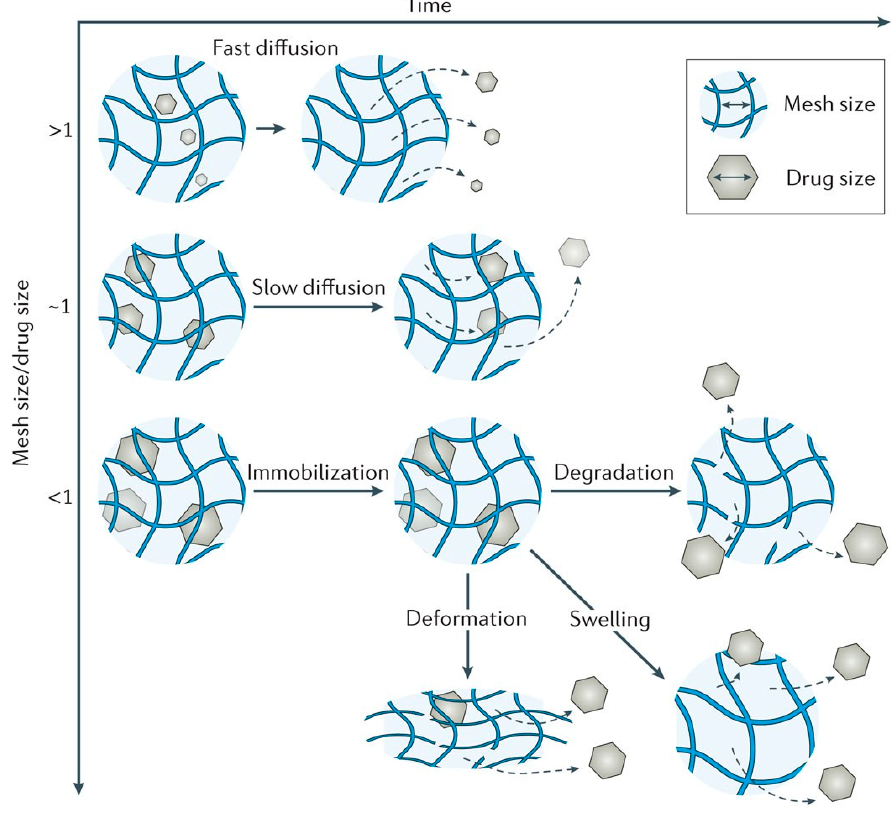
Figure 5. Mesh size mediates drug diffusion. [53].